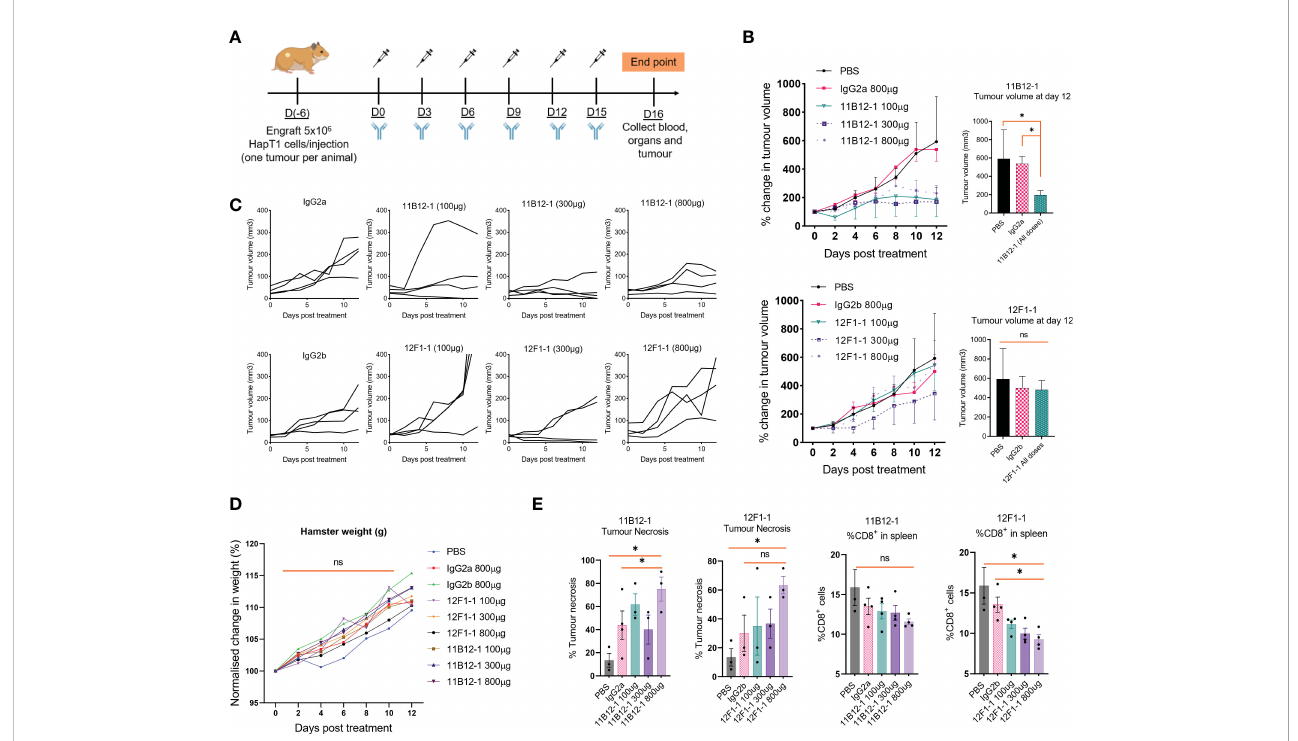
FIGURE 3 In vivo ef fi cacy of anti-PD-L1 clones 11B12-1 and 12F1-1 in a Syrian hamster model of pancreatic ductal adenocarcinoma. (A) Schematic of treatment scheme. HapT1 (heterotopic PDAC) bearing Syrian hamsters (n=4 per group) were intraperitoneally injected with PBS (Mock), IgG isotype controls (800 µg) or Syrian hamster anti-PD-L1 (11B12-1 or 12F1-1) at three doses (100, 300 or 800 µg) every three days for a total of 6 injections. (B) Mean percentage change in tumour volume for 11B12-1 (upper) and 12F1-1(lower) treated hamsters and respective controls with statistical signi fi cance shown to the right. (C) Individual tumour growth curves. (D) Percentage change in weight of hamsters after treatment with anti-PD-L1 clone ’ s 11B12-1 and 12F1-1. (E) Percentage of tumour necrosis and CD8 + cells in spleens of hamsters as determined by histopathological analysis and fl ow cytometry respectively. Data is normalized to day 0. All data and error bars are presented as mean ± SEM. Statistical signi fi cance for tumour growth controls was calculated using two-way mixed model ANOVA. All other data was calculated for statistical signi fi cance using an unpaired t-test with Welch ’ s correction. *p < 0.05, ns not signi fi